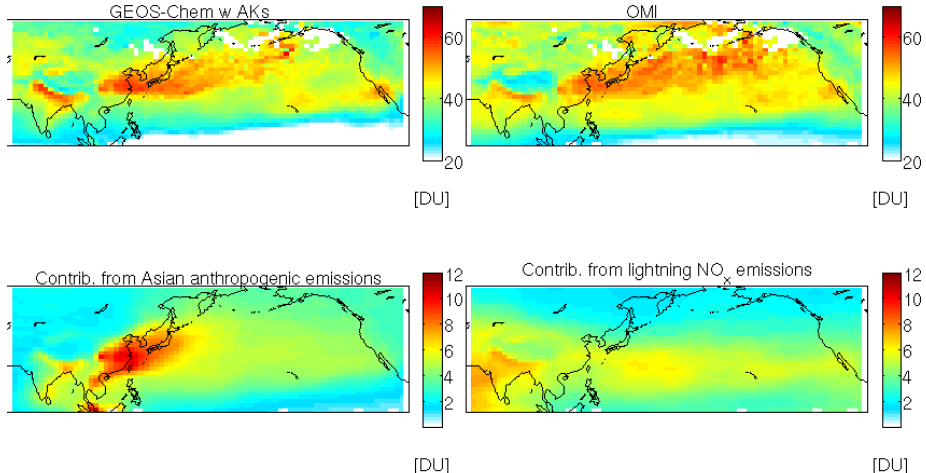
Fig. 9. Comparison between simulated and observed tropospheric ozone columns. The top row contains tropospheric ozone columns from the baseline simulation convolved with the OMI averaging kernels, and those retrieved from OMI by Liu et al. (2010). The bottom row shows simulated contributions to the tropospheric O 3 columns due to lightning NO x emissions and due to Asian anthropogenic emissions as determined by difference with simulations that exclude either source.